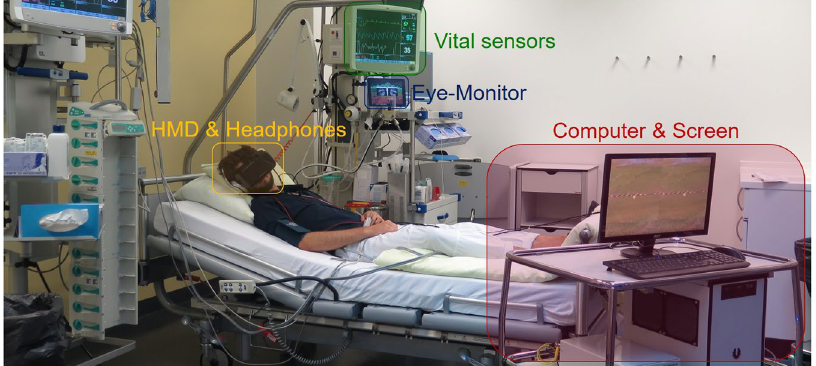
Figure 2. Participant lying on the bed in the ICU during stimulation, including the whole